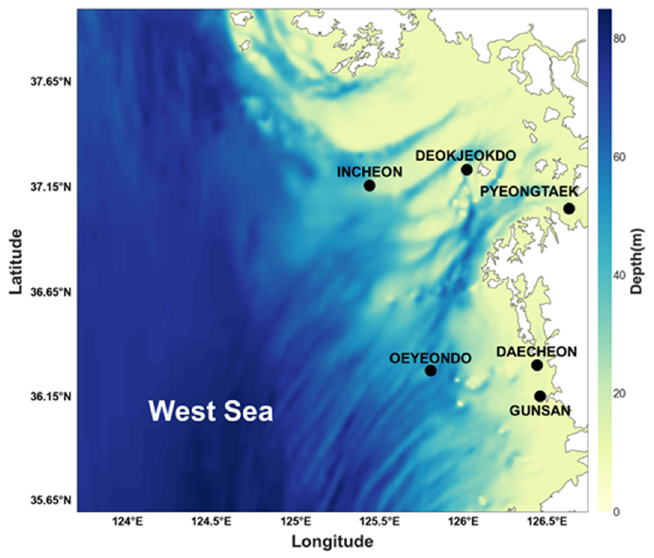
Figure 3. Model domain and bathymetry (Gyeonggi Bay). Dots indicate buoys’ locations.